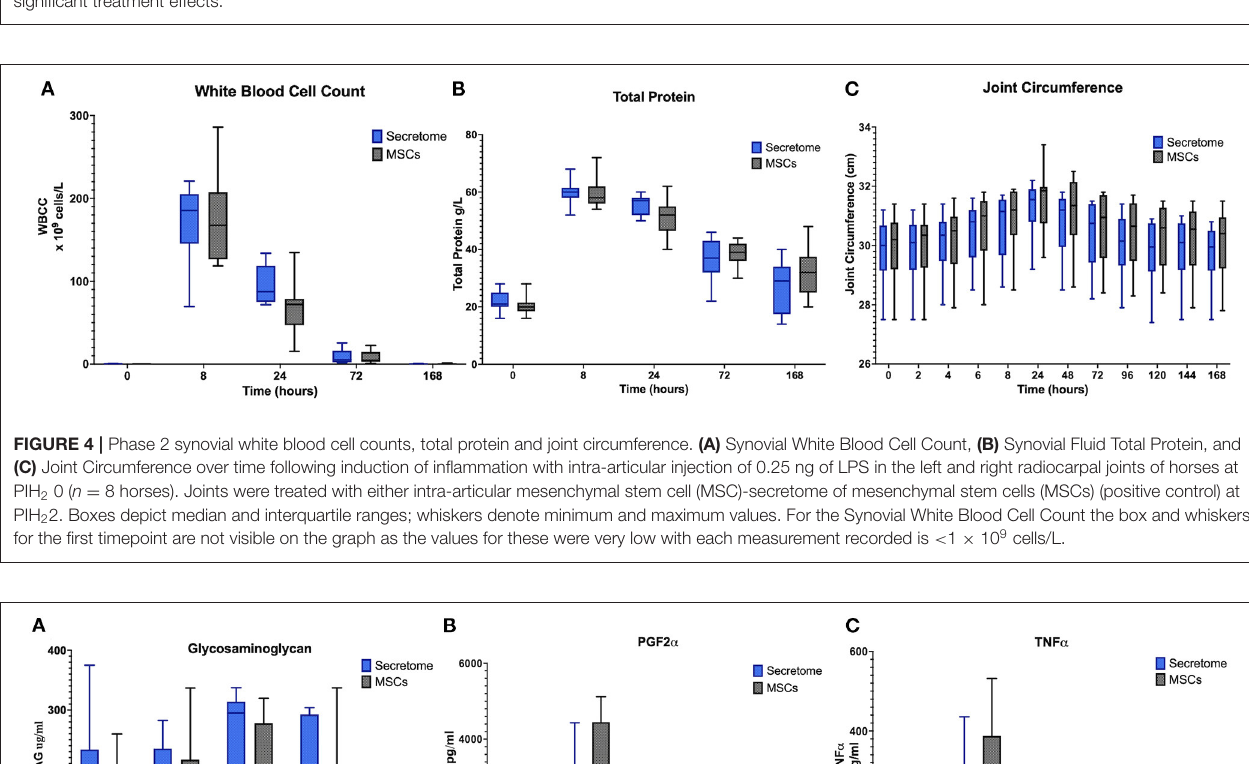
FIGURE 3 | Phase 1 synovial fluid glycosaminoglycan, prostaglandin F2 α and tumor necrosis factor α . (A) Glycosaminoglycan, (B) Prostaglandin F2 α , and (C) Tumor Necrosis Factor α concentrations in synovial fluid over time following induction of inflammation with intra-articular injection of 0.25 ng of LPS in the left and right radiocarpal joints of horses at PIH 1 0 ( n = 8 horses). Joints were treated with either intra-articular mesenchymal stem cell (MSC)-secretome or medium (negative control) at PIH 1 2. Boxes depict median and interquartile ranges; whiskers denote minimum and maximum values. *** p < 0.001, indicating timepoints where there are significant treatment effects.